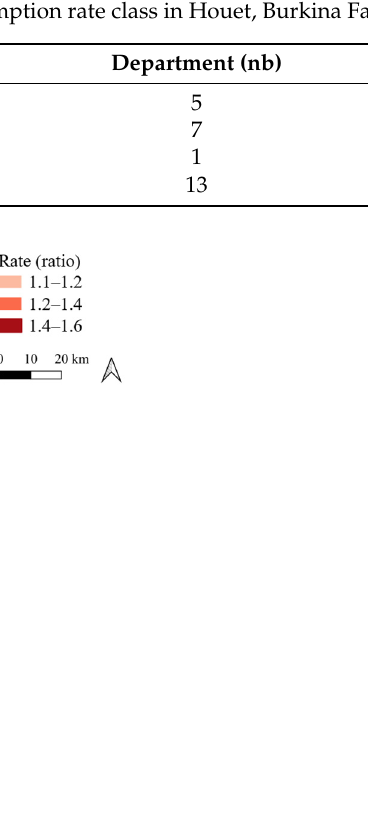
Figure 12. Land-consumption rate (SDG 11.3.1) between 2016 and 2020 in Houet, Burkina